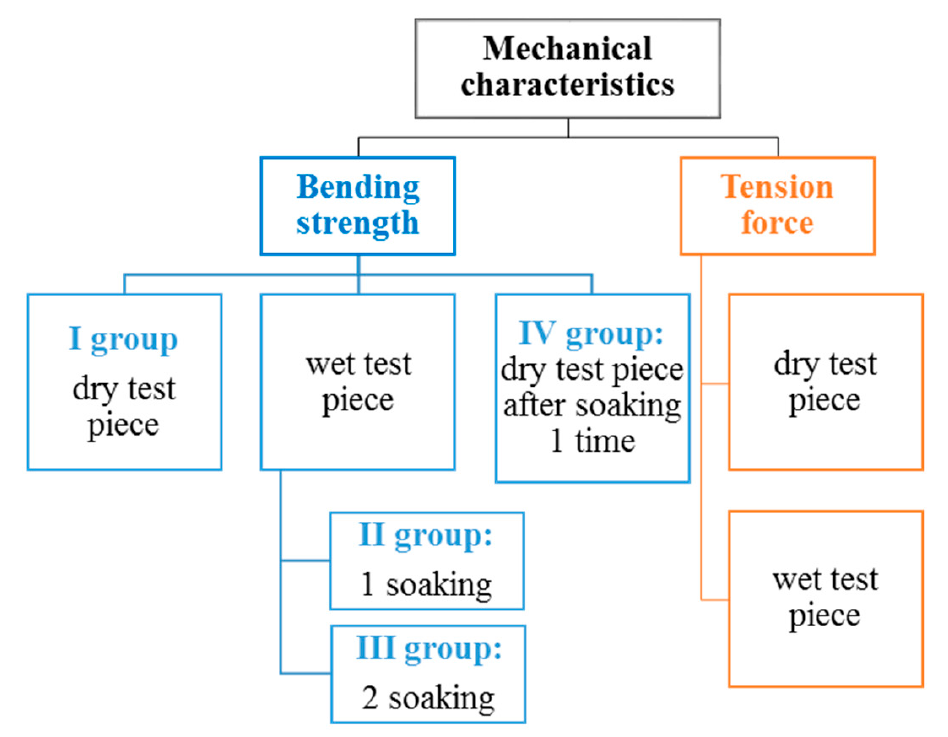
Figure 3. Test pieces for classification in order to determine mechanical properties.